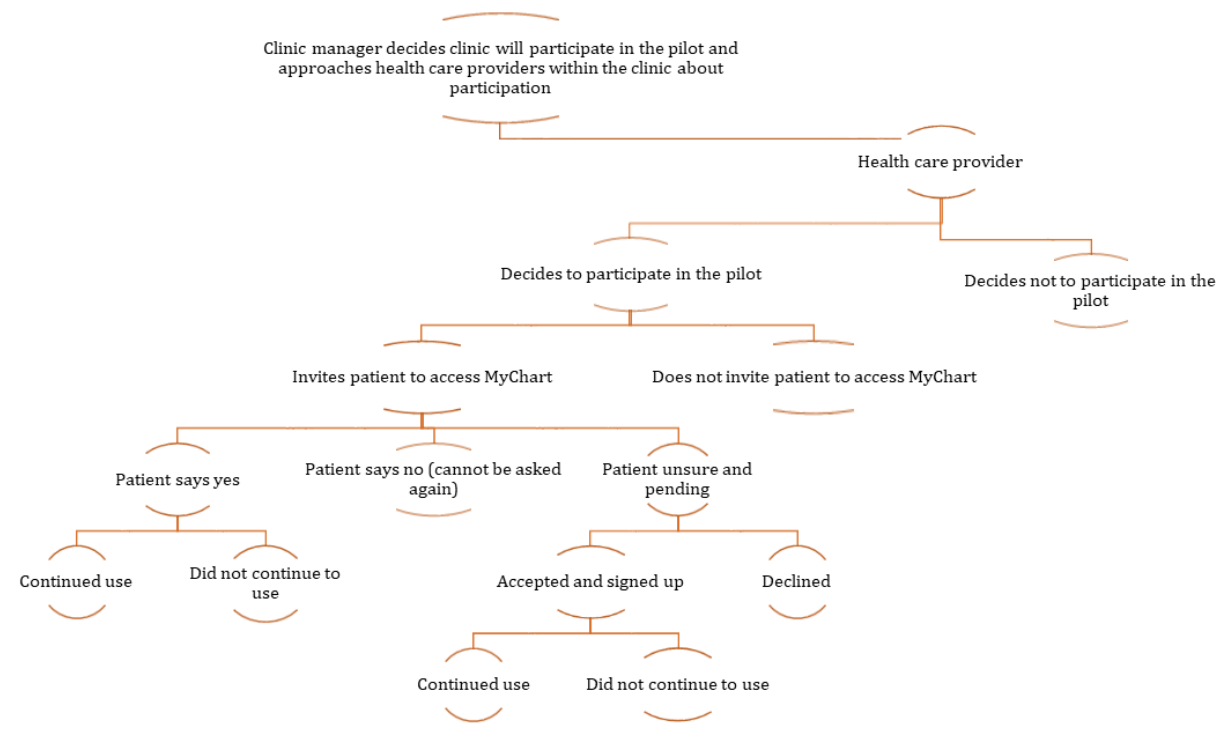
Figure 1. Participant recruitment